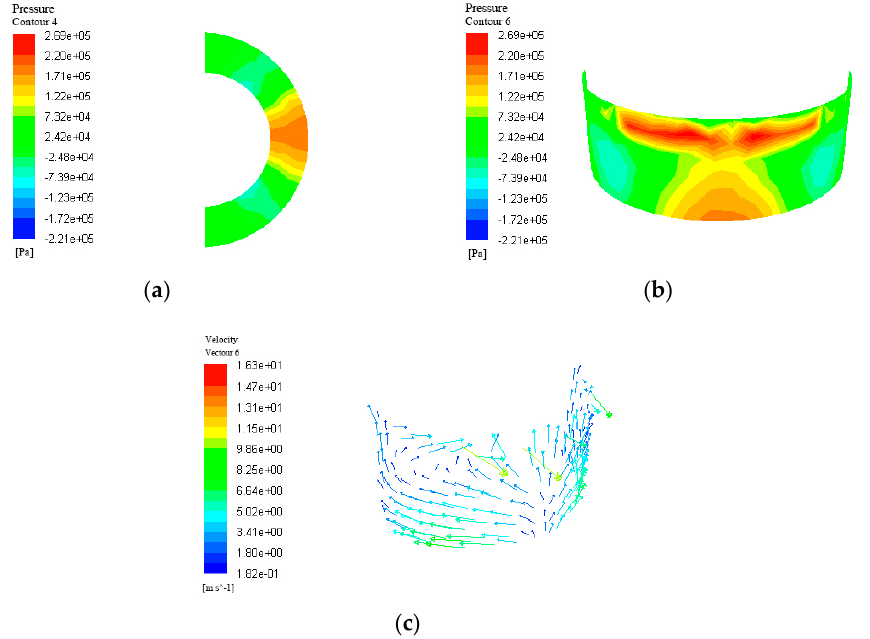
Figure 6. Cross-sectional and longitudinal section pressure distribution and flow velocity vector distribution of fluid in semicircular micro-textures: ( a ) cross-sectional pressure distribution; ( b ) longitudinal section pressure distribution; ( c ) longitudinal section speed vector distribution.